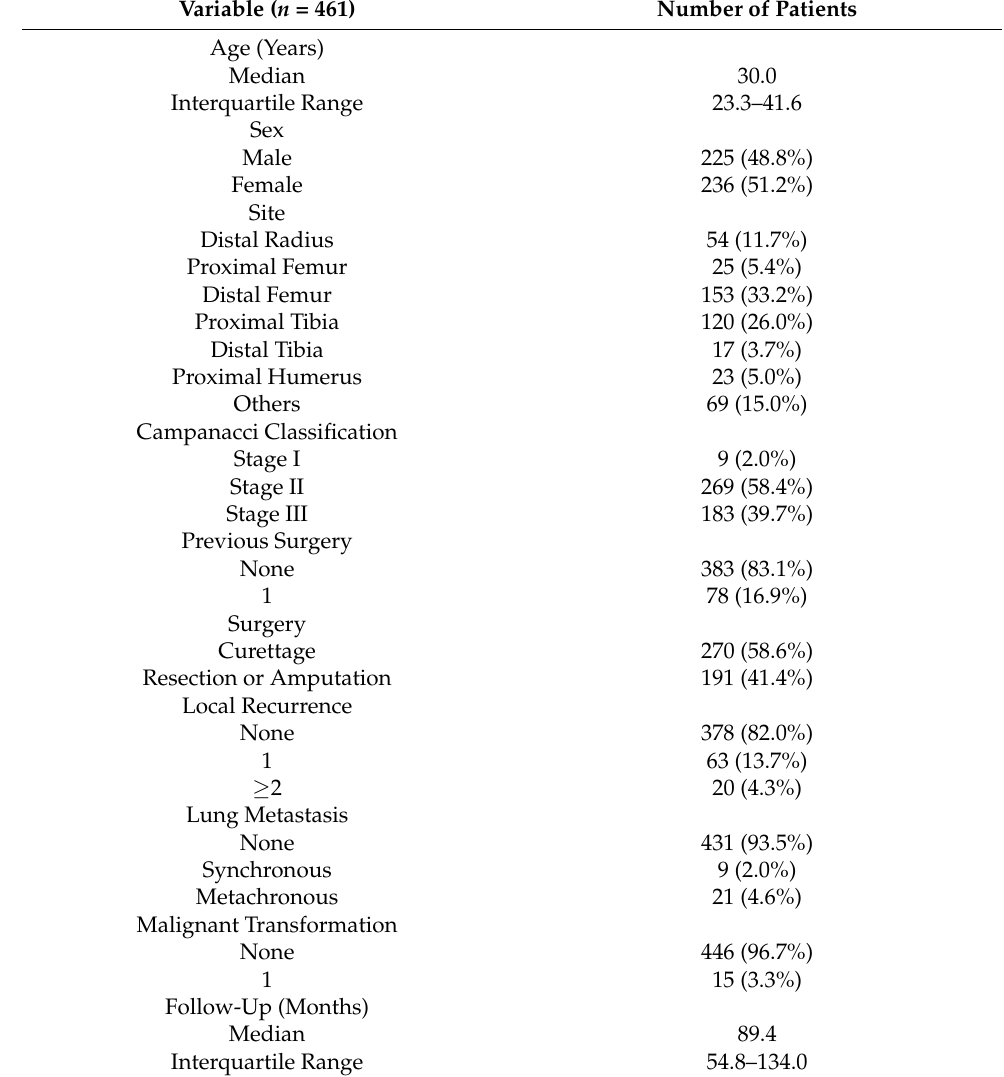
Table 1. Characteristics of patients included in this